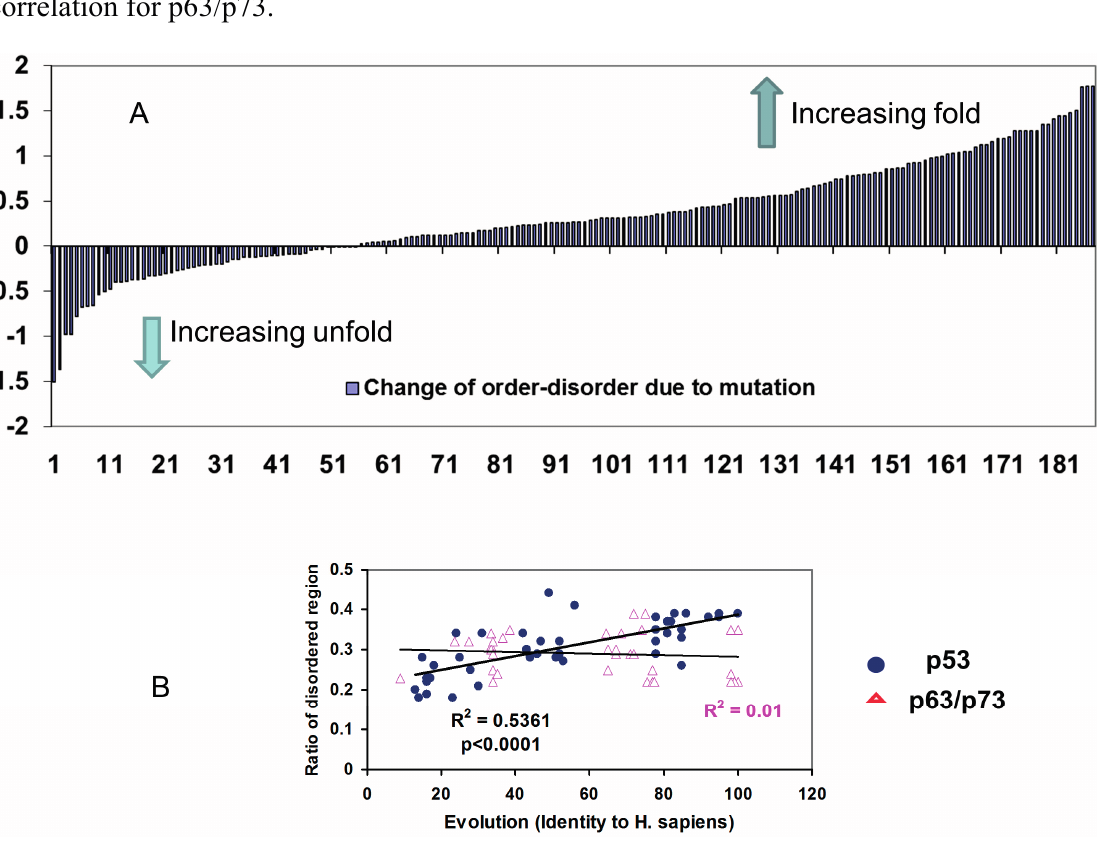
Figure 5. Evolution optimized p53 to have more structural disorder and p53 mutations